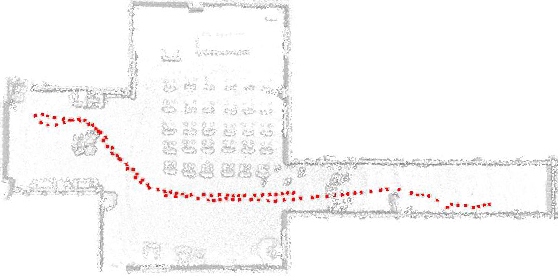
Figure 3. Trajectory of the robot performing a survey in the second test case